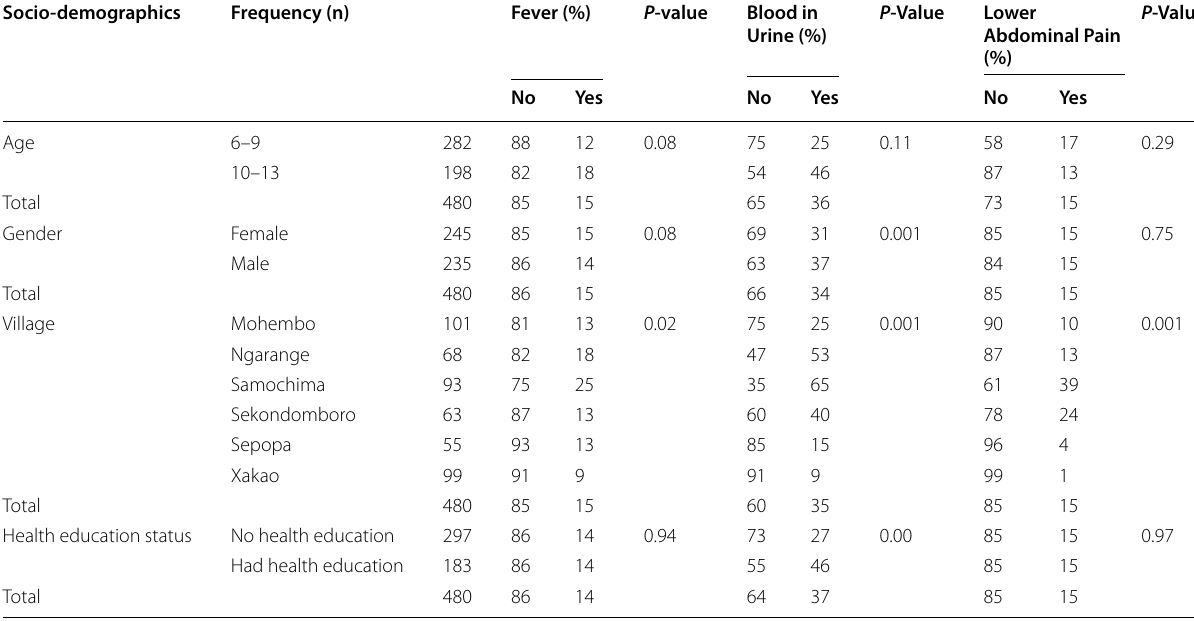
Table 4 Knowledge of signs and symptoms of schistosomiasis by demographic characteristics Socio‑demographics